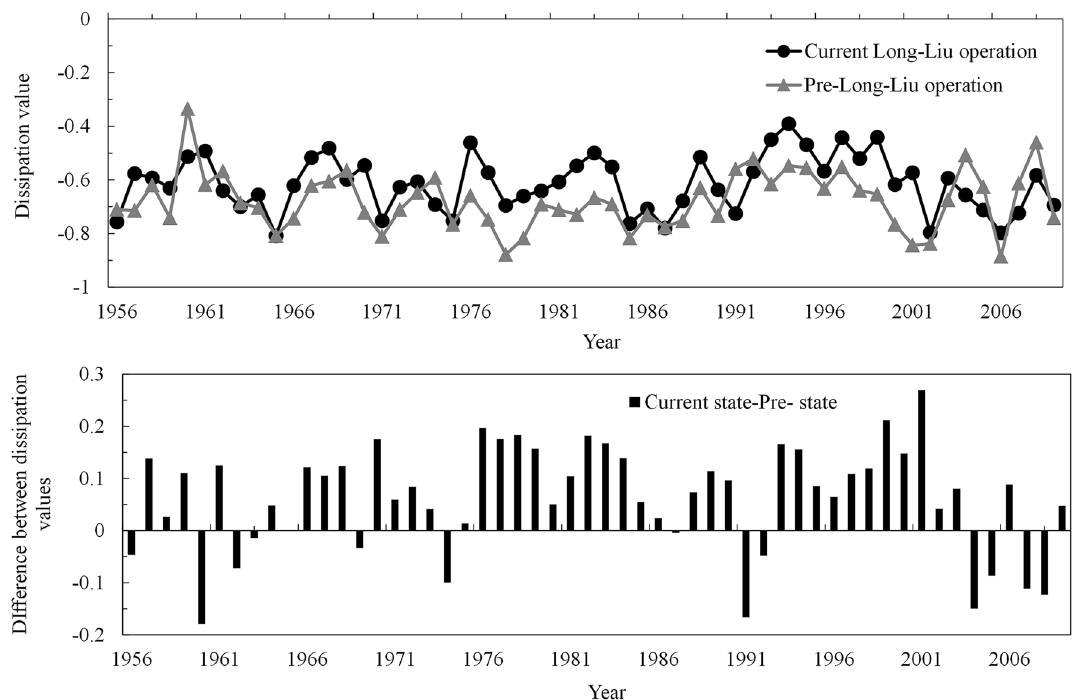
Figure 7. Comparison of the joint development level of the water–sediment–electricity system in the current situation and pre-Long-Liu operation